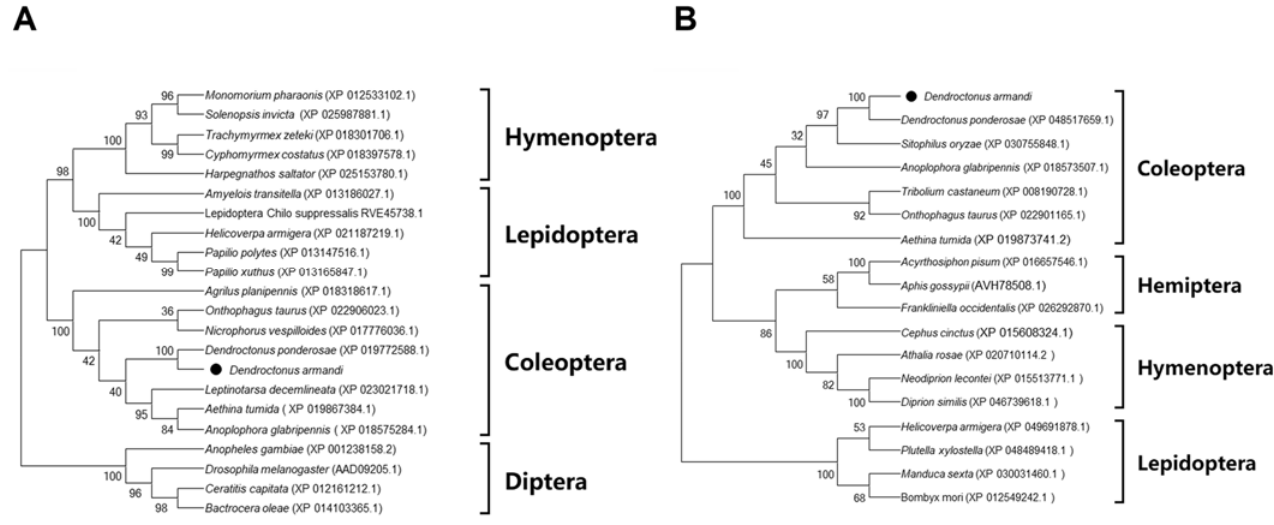
Figure 1. Phylogenetic analysis of D. armandi AhR ( A ) and ARNT ( B ) with other insect species. The phylogenetic tree was constructed in MEGA 6.0 using the neighbor-joining method. Bootstrap values (1000 replicates) are indicated next to the branches, and GenBank accession numbers are shown in parentheses. The black dot indicates D. armandi AhR and ARNT.